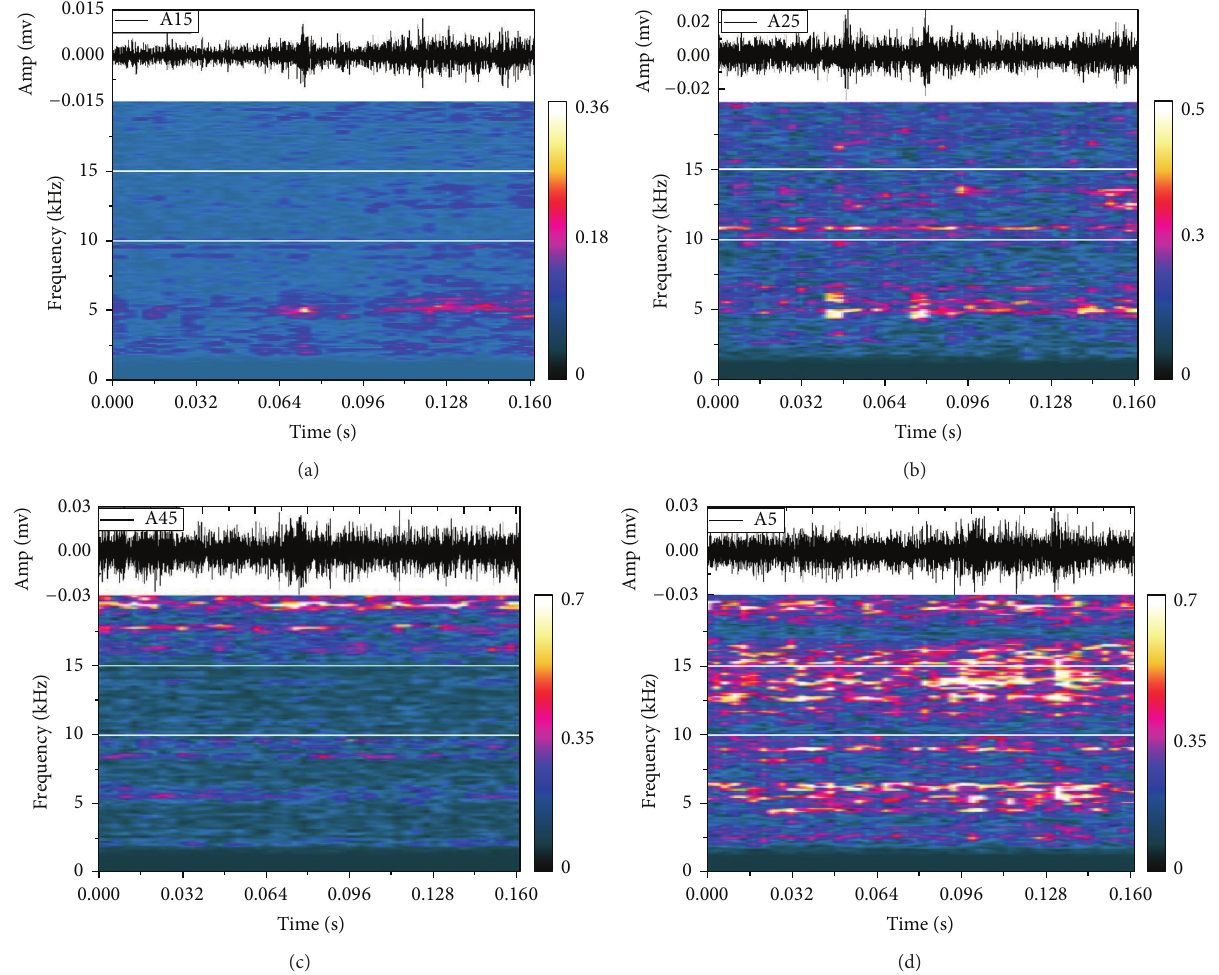
Figure 2: STFT analysis of sand production vibration signals: (a) number A15 well; (b) number A25 well; (c) number A45 well; (d) number A5